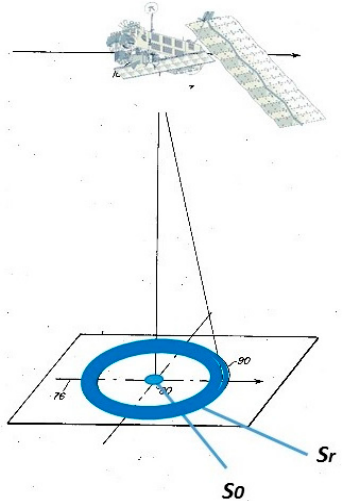
Figure 1. Range annuli for a single echo. The pattern moves along the satellite’s nadir track line with each successive radar echo.